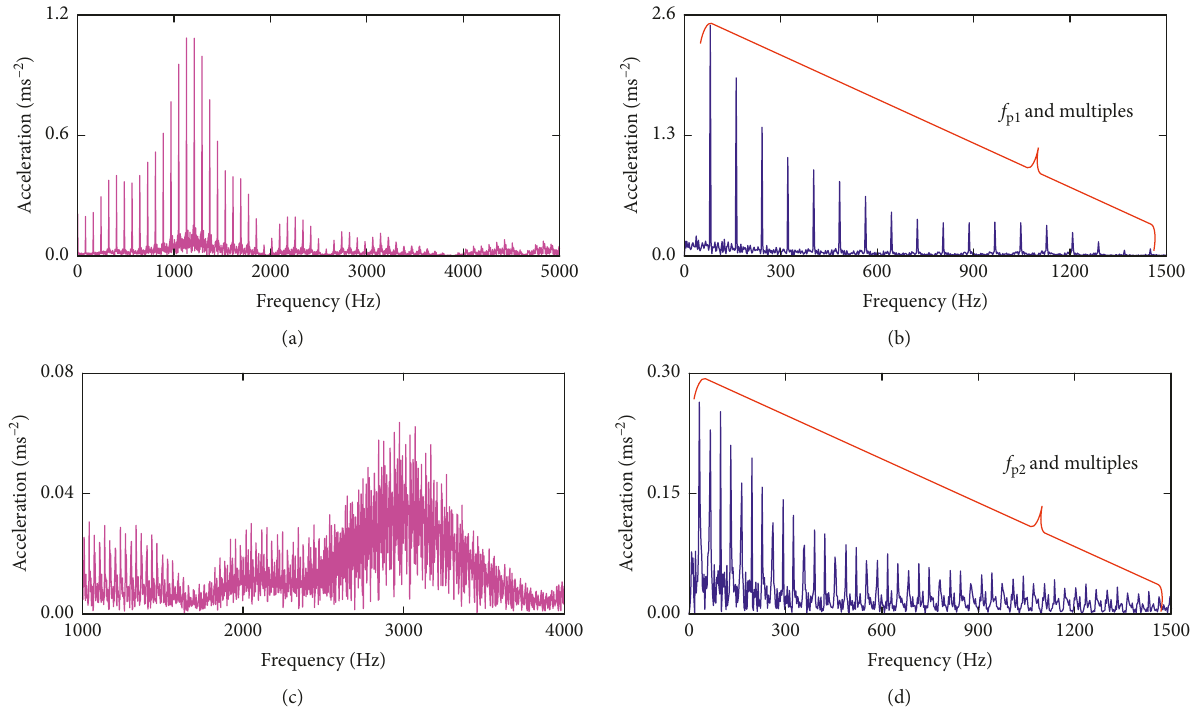
Figure 18: (a) Fourier spectra of the extracted IRS1; (b) Hilbert envelope spectra of the extracted IRS1; (c) Fourier spectra of the extracted IRS2; (d) Hilbert envelope spectra of the extracted